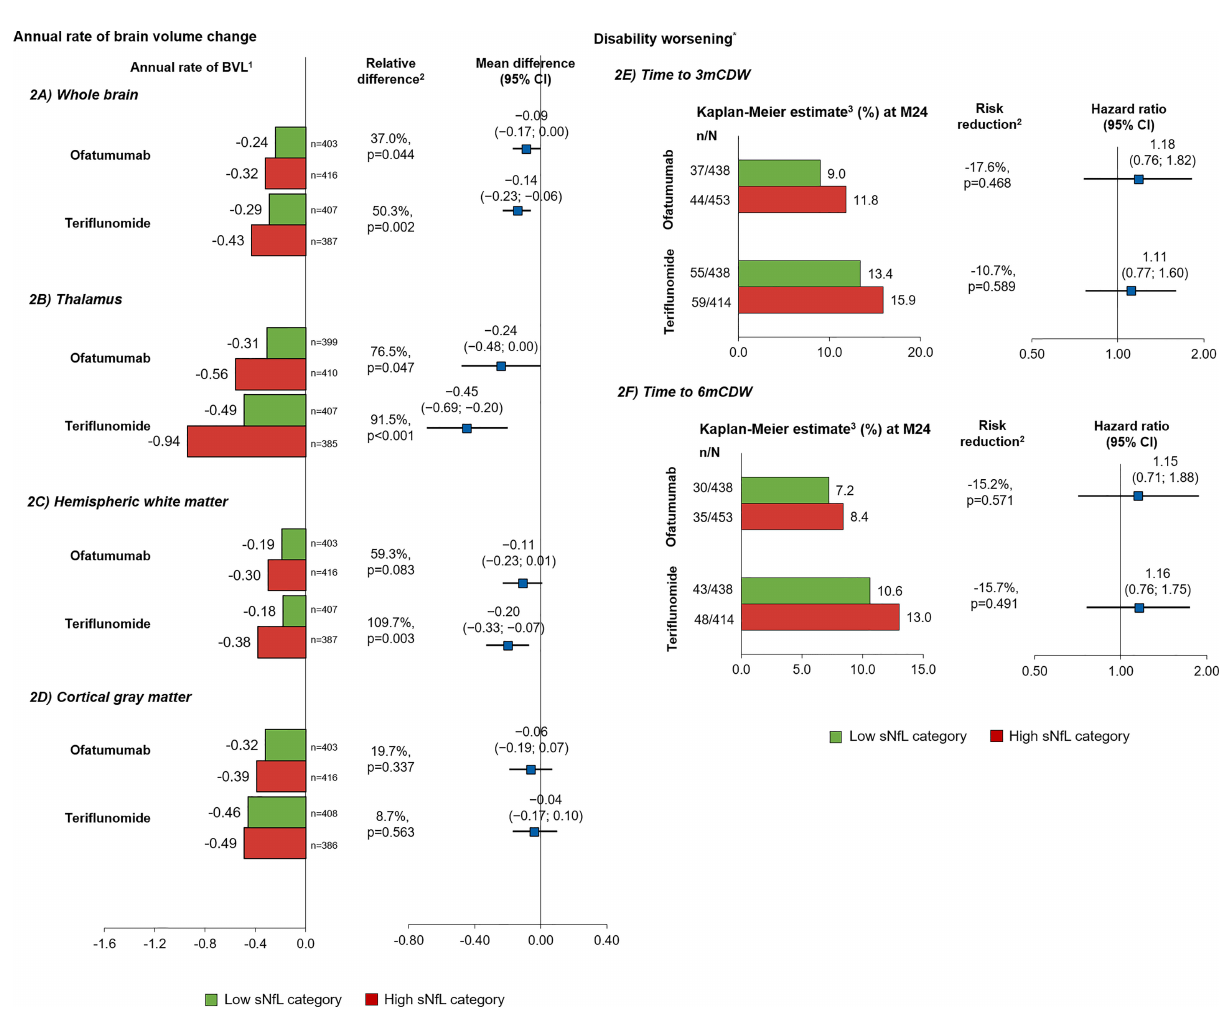
consistent for reduction in thalamic volume loss with relative reduction of 40.6% ( − 0.56 vs. − 0.94, p=0.003) ( Figure 5D ) but not statistically signi fi cant for WM or cGM volume loss. Greater effects of ofatumumab versus teri fl unomide on reducing 3mCDW and 6mCDW risk were noted irrespective of baseline sNfL levels, corresponding to 34% and higher risk reduction in patients with high sNfL and low sNfL ( Figures 5E, F ).